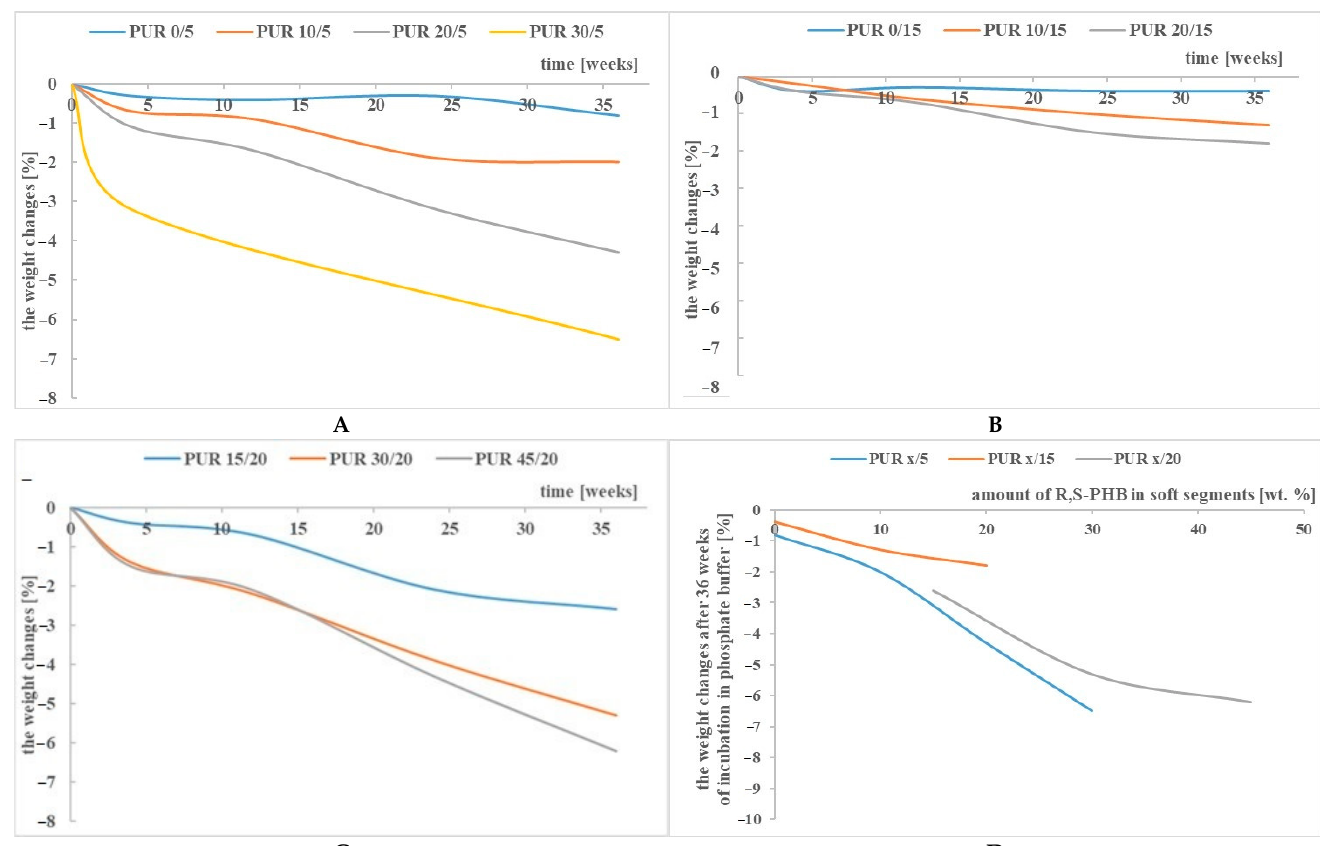
Figure 1. The weight changes of PUR x/5 ( A ), PUR x/15 ( B ) and PUR x/20 ( C ) after incubation in buffer solution, and dependence of the weight changes after 36 weeks of incubation on the amount of R,S-PHB in the structure of PURs soft segments ( D ).